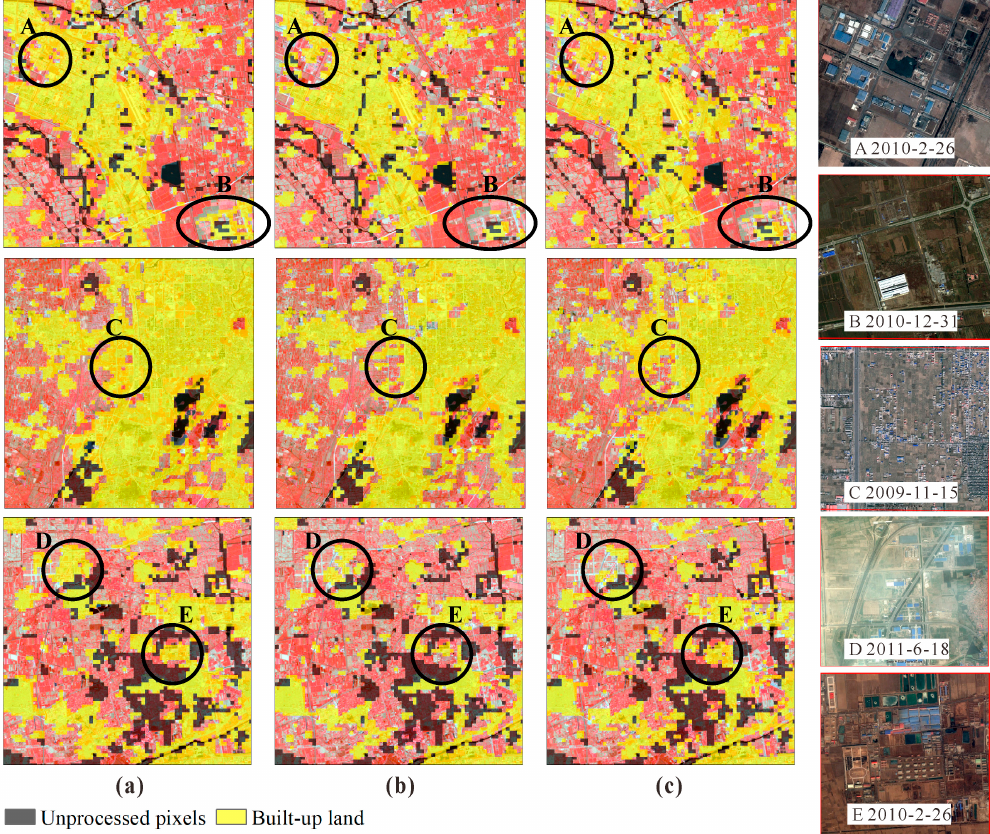
Figure 14. The subset images of the land-cover maps for 2010 (overlaid on the Landsat TM images). ( a ) Land-cover maps generated from the proposed algorithm are shown in the first column; ( b ) Land-cover maps generated from RF-TF are shown in the second column; ( c ) Land-cover maps generated from CCDC are shown in the third column. Areas showing inconsistent classification results are marked with ellipses and are indexed as A-E, whose corresponding Google Earth high-resolution images are shown in the rightmost column. Table 1. Change detection assessment of the proposed method.